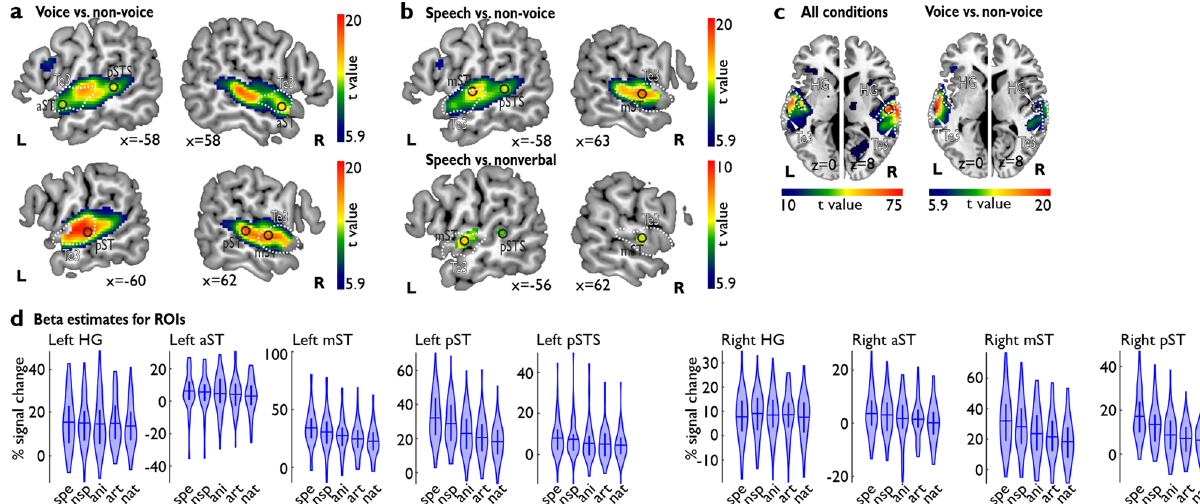
Fig. 1 Neural AC activity for voice and speech processing. Contrast images were thresholded at p < 0.05 including a voxel-wise FWE correction ( n = 52 human participants). White dashed outline represents the auditory region Te3. a TVA in bilateral AC for contrasting voice against non-voice sounds. Four peak locations were found in left AC, with three peaks located within the auditory region Te3 (aST, mST, pST) and one posterior to Te3 in posterior superior temporal sulcus (pSTS). Two peaks in the right AC were located inside Te3 (aST, mST) and one posterior to Te3 in pST. b Contrasting speech against non-voice sounds [Speech vs. non.voice] revealed two left AC peaks (mST, pSTS) and one right peak (mST); these peak activations were con fi rmed when speci fi cally contrasting speech against nonverbal voices [speech vs. nonverbal]. c AC activity for all fi ve conditions compared against baseline [all conditions], with speci fi c peaks in bilateral HG that were also located inside the TVA [voice vs. non-voice]. d Violin plots for the percent signal change quanti fi ed from beta estimates for all fi ve conditions ( spe speech, nsp nonspeech/nonverbal, ani animal, art arti fi cial, nat natural sounds) for all ROIs (built as a sphere of a 3 mm radius around peak locations); horizontal bar indicates the mean, the inner vertical indicates the fi rst to third quantile of the data